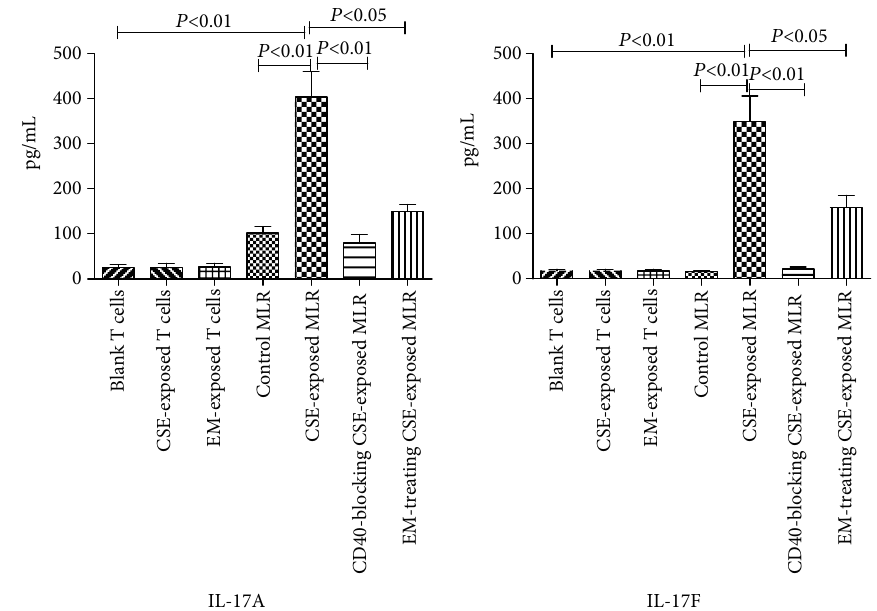
Figure 4: E ff ects of EM on the secretion of IL-17A and IL-17F in the CSE-exposed DC/MLR group. The levels of IL-17A and IL-17F were evaluated using Quantibody array kits ( n = 6 ). (The height of the bar chart represents the mean and the height of the error line indicates the standard errors of the means in the